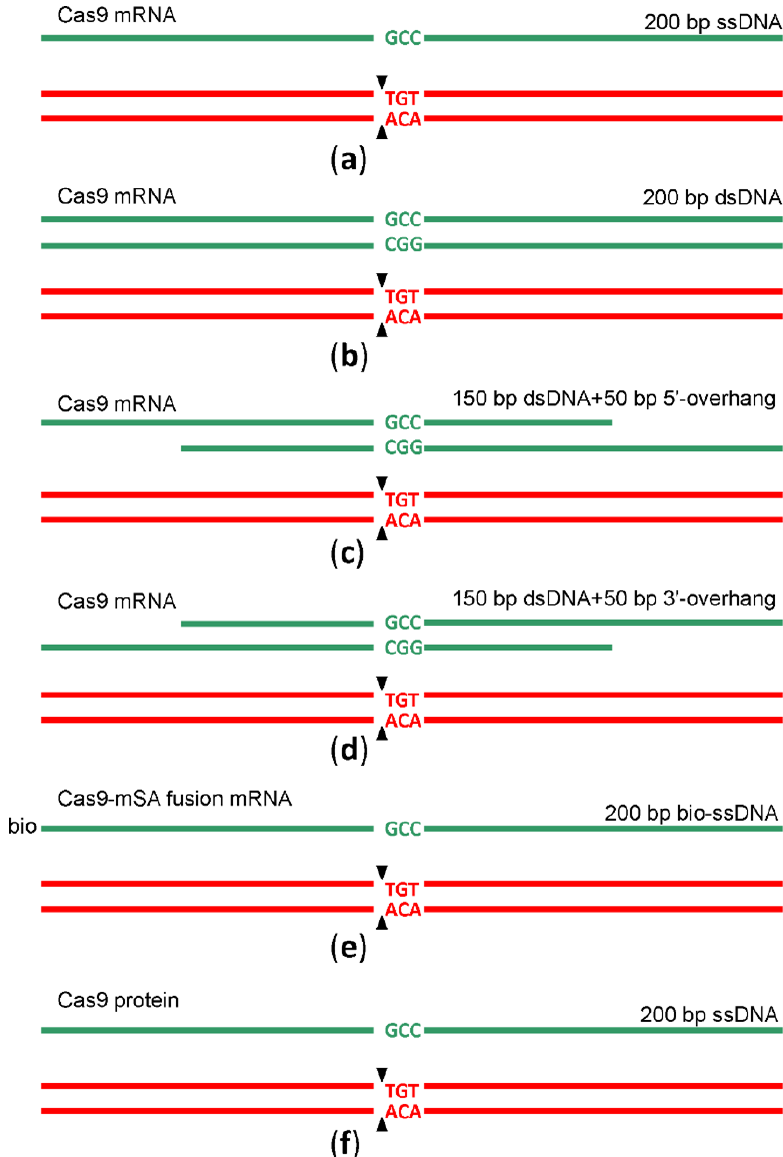
Figure 3. Scheme of genome editing by sgRNA guided cleavage and HR. The cleavage site is marked by black arrows. Red and green nucleotides mark the wild type and edited sequences. DNA templates used for HR are shown as green lines. ( a ) Scheme of genome editing by sgRNA directed cleavage and ssDNA guided HR; Cas9 was provided by injection of Cas9 mRNA. ( b ) Scheme of genome editing by sgRNA directed cleavage and dsDNA guided HR; Cas9 was provided by injection of Cas9 mRNA. ( c ) Scheme of genome editing by sgRNA directed cleavage and HR guided by DNA template with 5′-overhang; Cas9 was provided by injection of Cas9 mRNA. ( d ) Scheme of genome editing by sgRNA directed cleavage and HR guided by DNA template with 3′-overhang; Cas9 was provided by injection of Cas9 mRNA. ( e ) Scheme of genome editing by sgRNA directed cleavage and biotinylated ssDNA guided HR; Cas9-mSA was provided by injection of Cas9-mSA mRNA. ( f ) Scheme of genome editing by sgRNA directed cleavage and ssDNA guided HR; Cas9 was provided by injection of Cas9 protein.